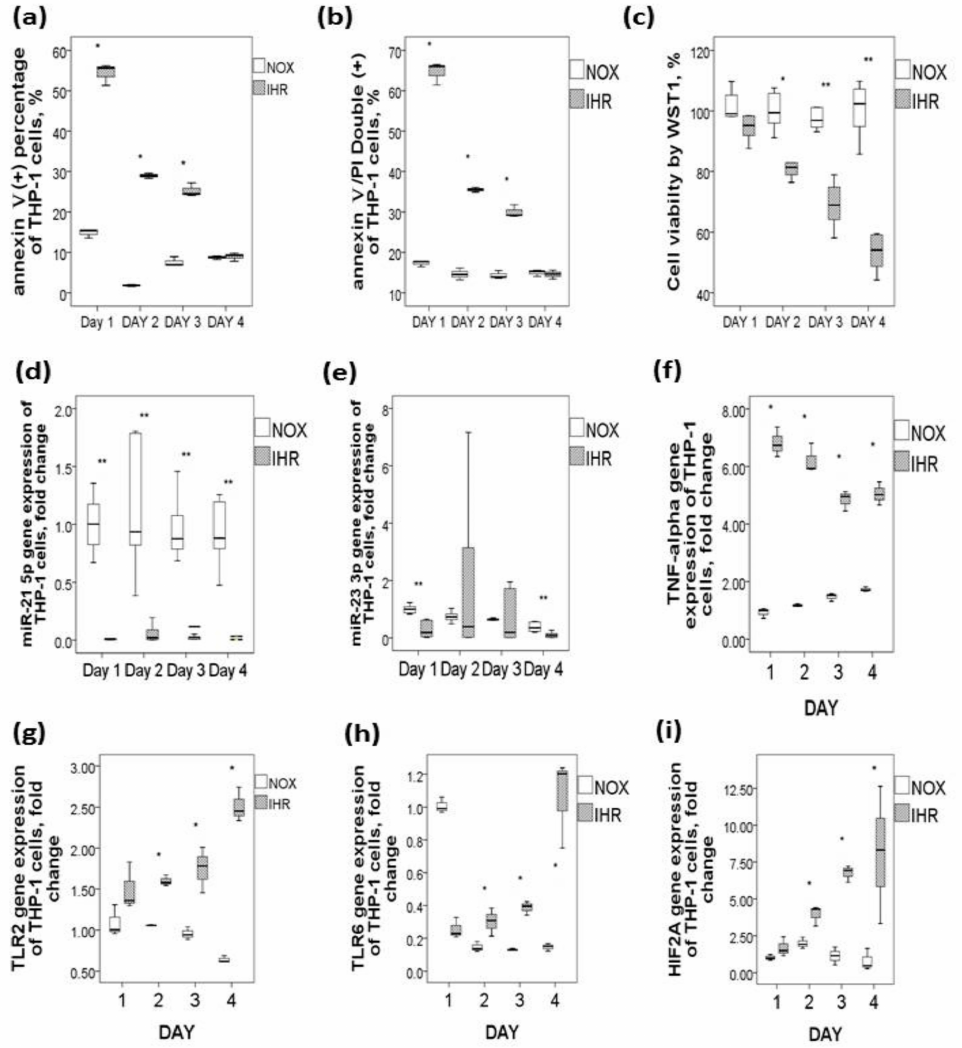
Figure 2. Downregulations of miR-21-5p / miR-23a-3p and upregulations of their predicted genes along with increased apoptosis in response to intermittent hypoxia with re-oxygenation (IHR) stimuli versus normoxic (NOX) condition in THP-1 cells. IHR in vitro for 1–4 days resulted in ( a ) increased early apoptosis marker, ( b ) increased late apoptosis marker, ( c ) decreased cell viability, ( d ) decreased miR-21-5p expression, ( e ) decreased miR-23a-3p expression, ( f ) increased TNF- α , ( g ) increased TLR2 , ( h ) increased TLR6 , and ( i ) increased HIF2- α gene expressions. * p < 0.05, compared between IHR and NOX condition by Mann–Whitney test; ** p < 0.01, compared between IHR and NOX condition by Mann-Whitney